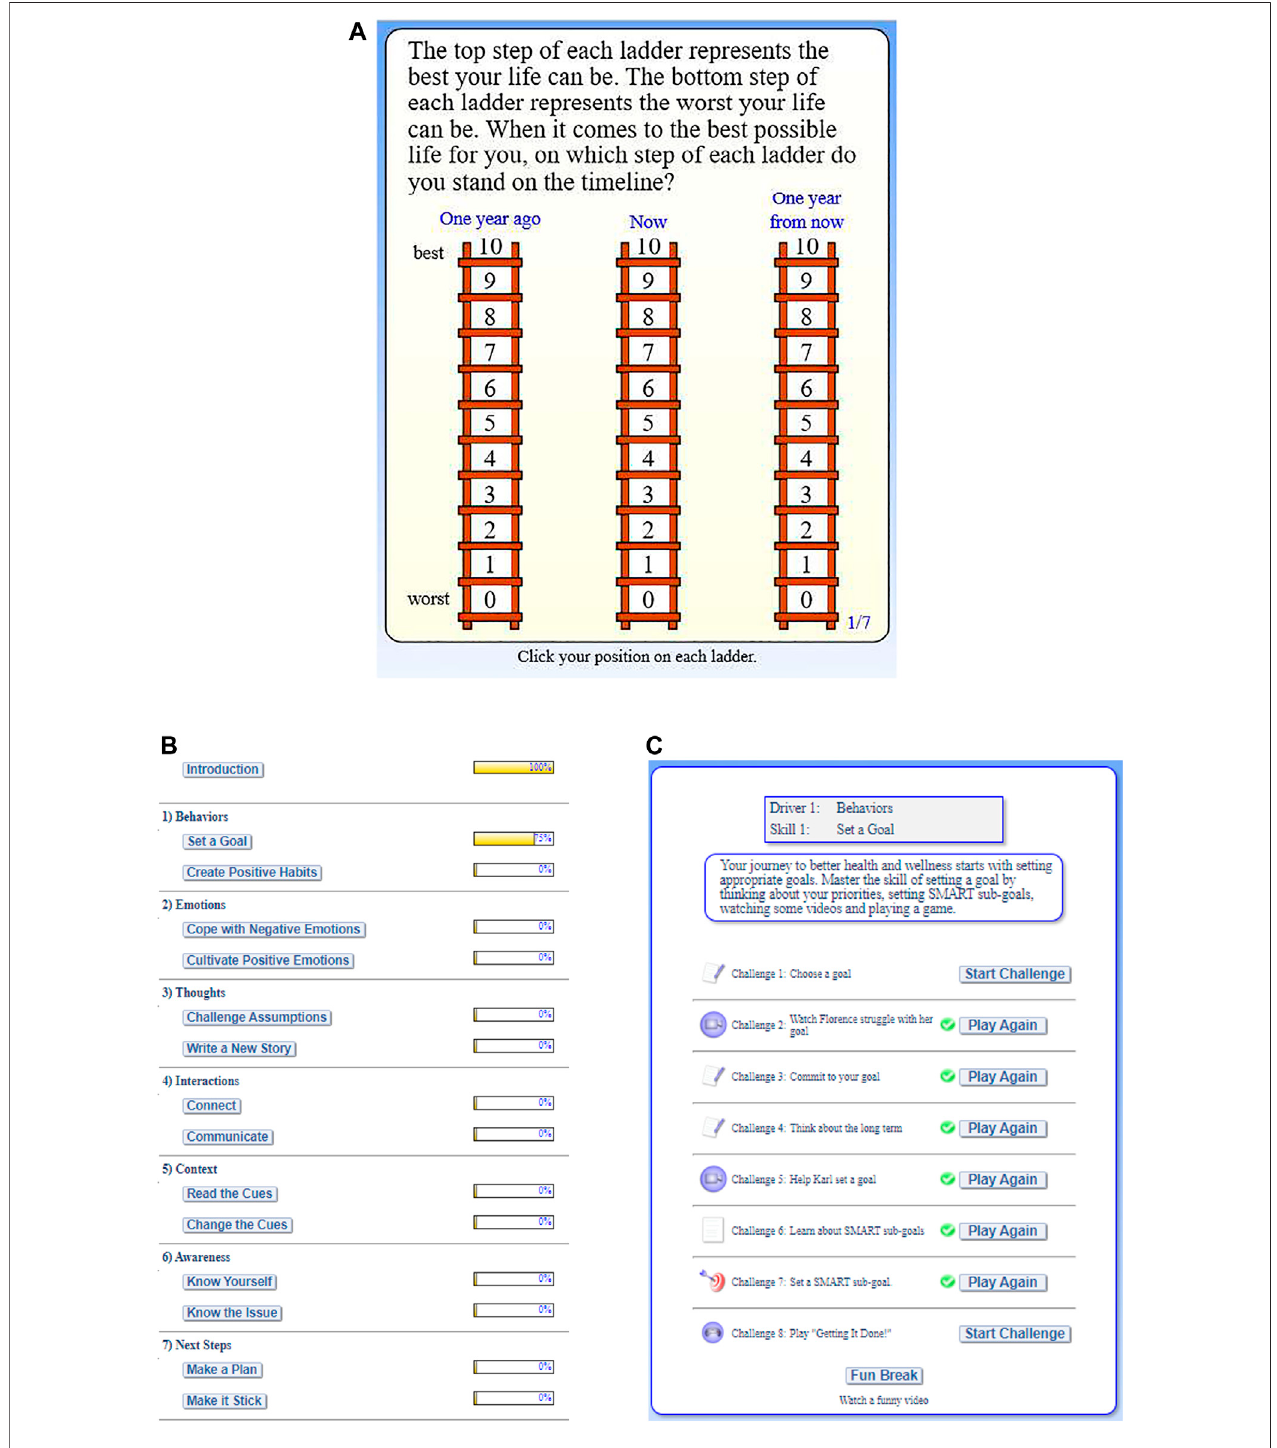
FIGURE2| FFWsamplepages (A) Examplechallenge:Interactivewell-beingassessment(ICOPPE) (B) Progressindicatorsandlinkstochallengesets (C) Linksto challenges with guidance and achievement indicators .